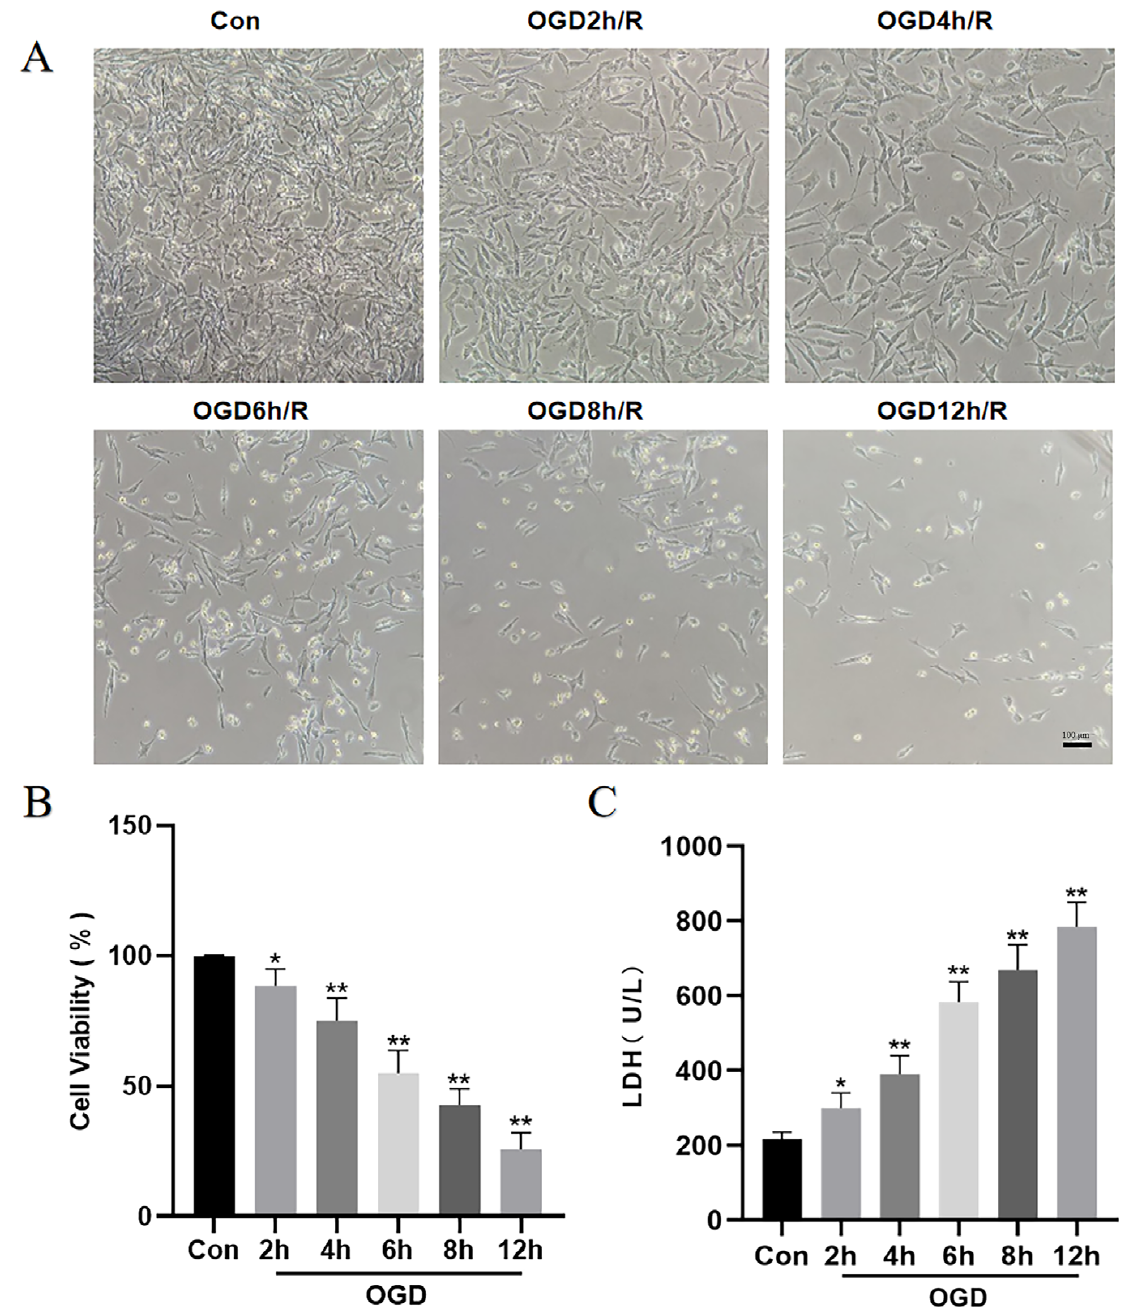
Figure 1. The different OGD time points on cell viability. ( A ) Live cell images captured by a light microscope from HT22 cells subjected to OGD treatments of varying intervals (2-, 4-, 6-, 8-, or 12-hrs), after which reoxygenation continues for another 24 h ( × 100; scale bar, 100 µ m). ( B ) Viability of cells post-OGD at different time frames, accompanied by reoxygenation (MTT assay). ( C ) The release of LDH in each group. Statistics were reported using a mean ± SD format. A minimum of three separate repetitions of the experiments yielded the same results. * p < 0.05, ** p < 0.01 vs. Con group.